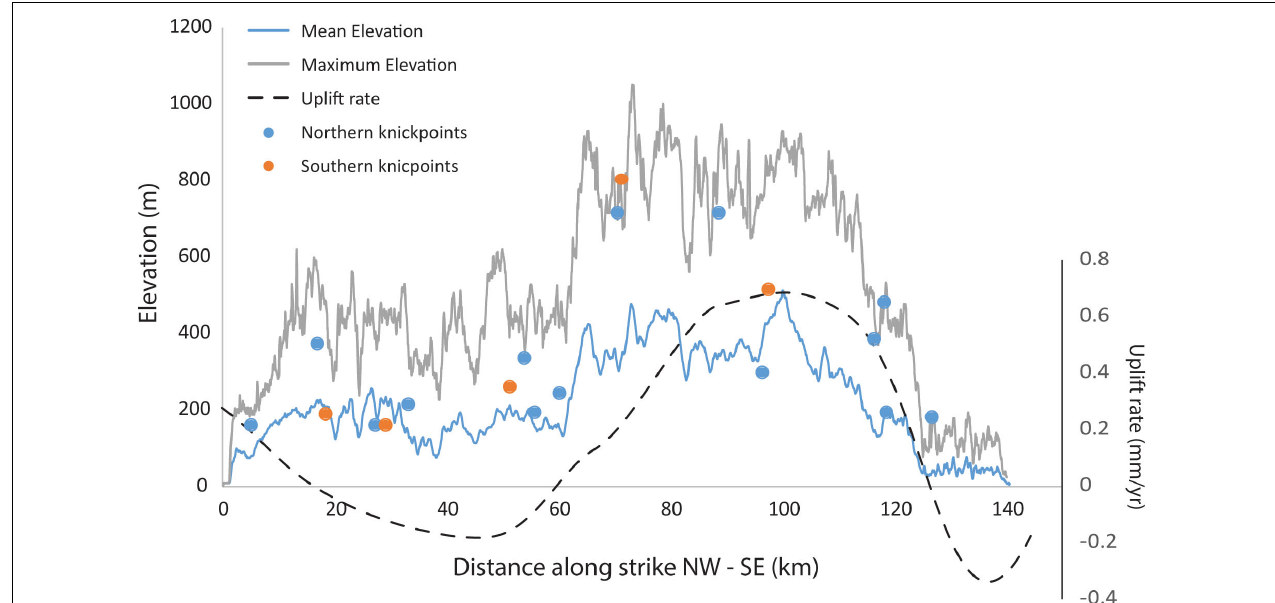
FIGURE 12 | Graph showing the distance along the strike of the island axis from NW – SE against mean (blue) and maximum (gray) elevation, knickpoint elevation (blue north/orange south) and interpolated uplift field for the island of